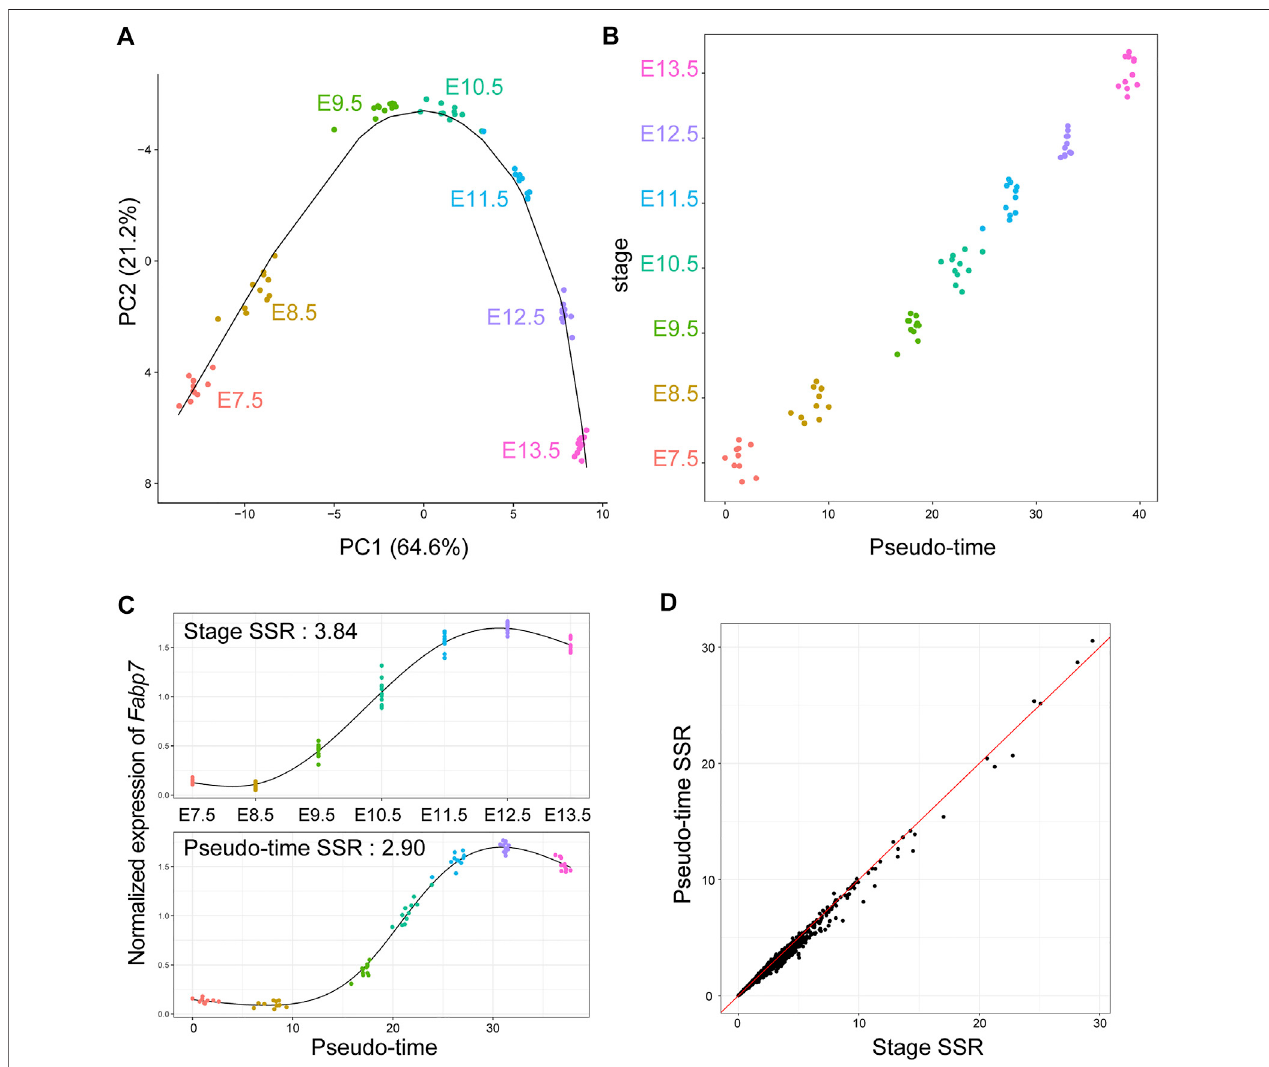
FIGURE 1 | Pseudo-time analysis for time-course individual bulk RNA-Seq of mouse embryos in early development. (A) Transcriptomic trajectory of mouse embryosfromE7.5toE13.5.EachpointonthePC1-PC2planeindicateseachindividualRNA-Seqresult.Thesolidlineindicatesaninferredtrajectorybyslingshot. (B) A scatterplot of pseudo-time and corresponding stage for each sample. Each point indicates each individual RNA-Seq result and is jittered along the Y -axis. (C) An example(Fabp7)ofdifferenceingeneexpressiondynamicsalongstageandpseudo-time.Theblacklinesindicatesmoothingcurvesforeachdata.Sumofsquared residuals (SSRs) between the observed and fi tted values were calculated. (D) A scatterplot of SSR of normalized gene expression of all genes along stage and pseudo- time. The red line indicates the same value between stage and